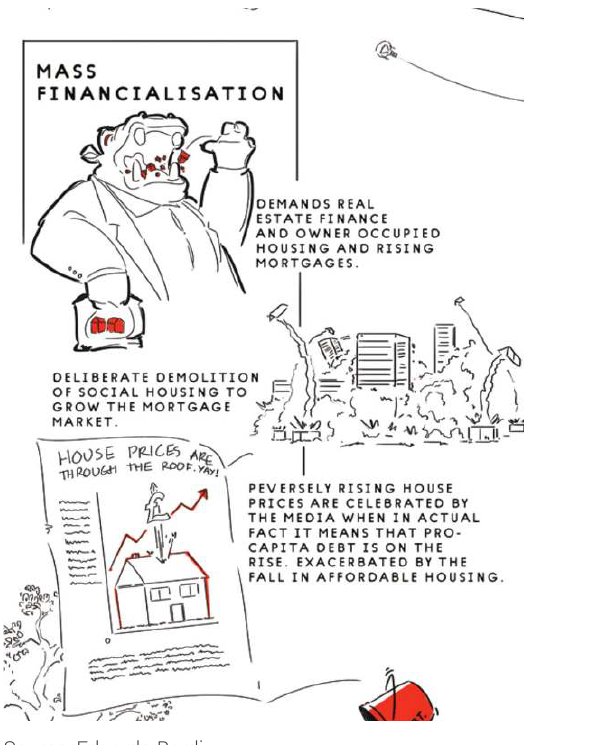
Source: Eduardo Bardi.